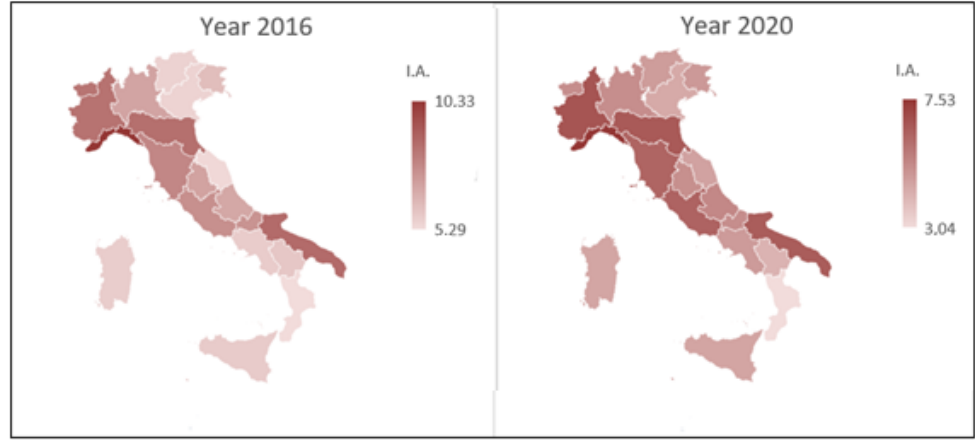
Figure 2. Cartogram of the Italian territory according to IA standardized rates (years 2016 and 2020).